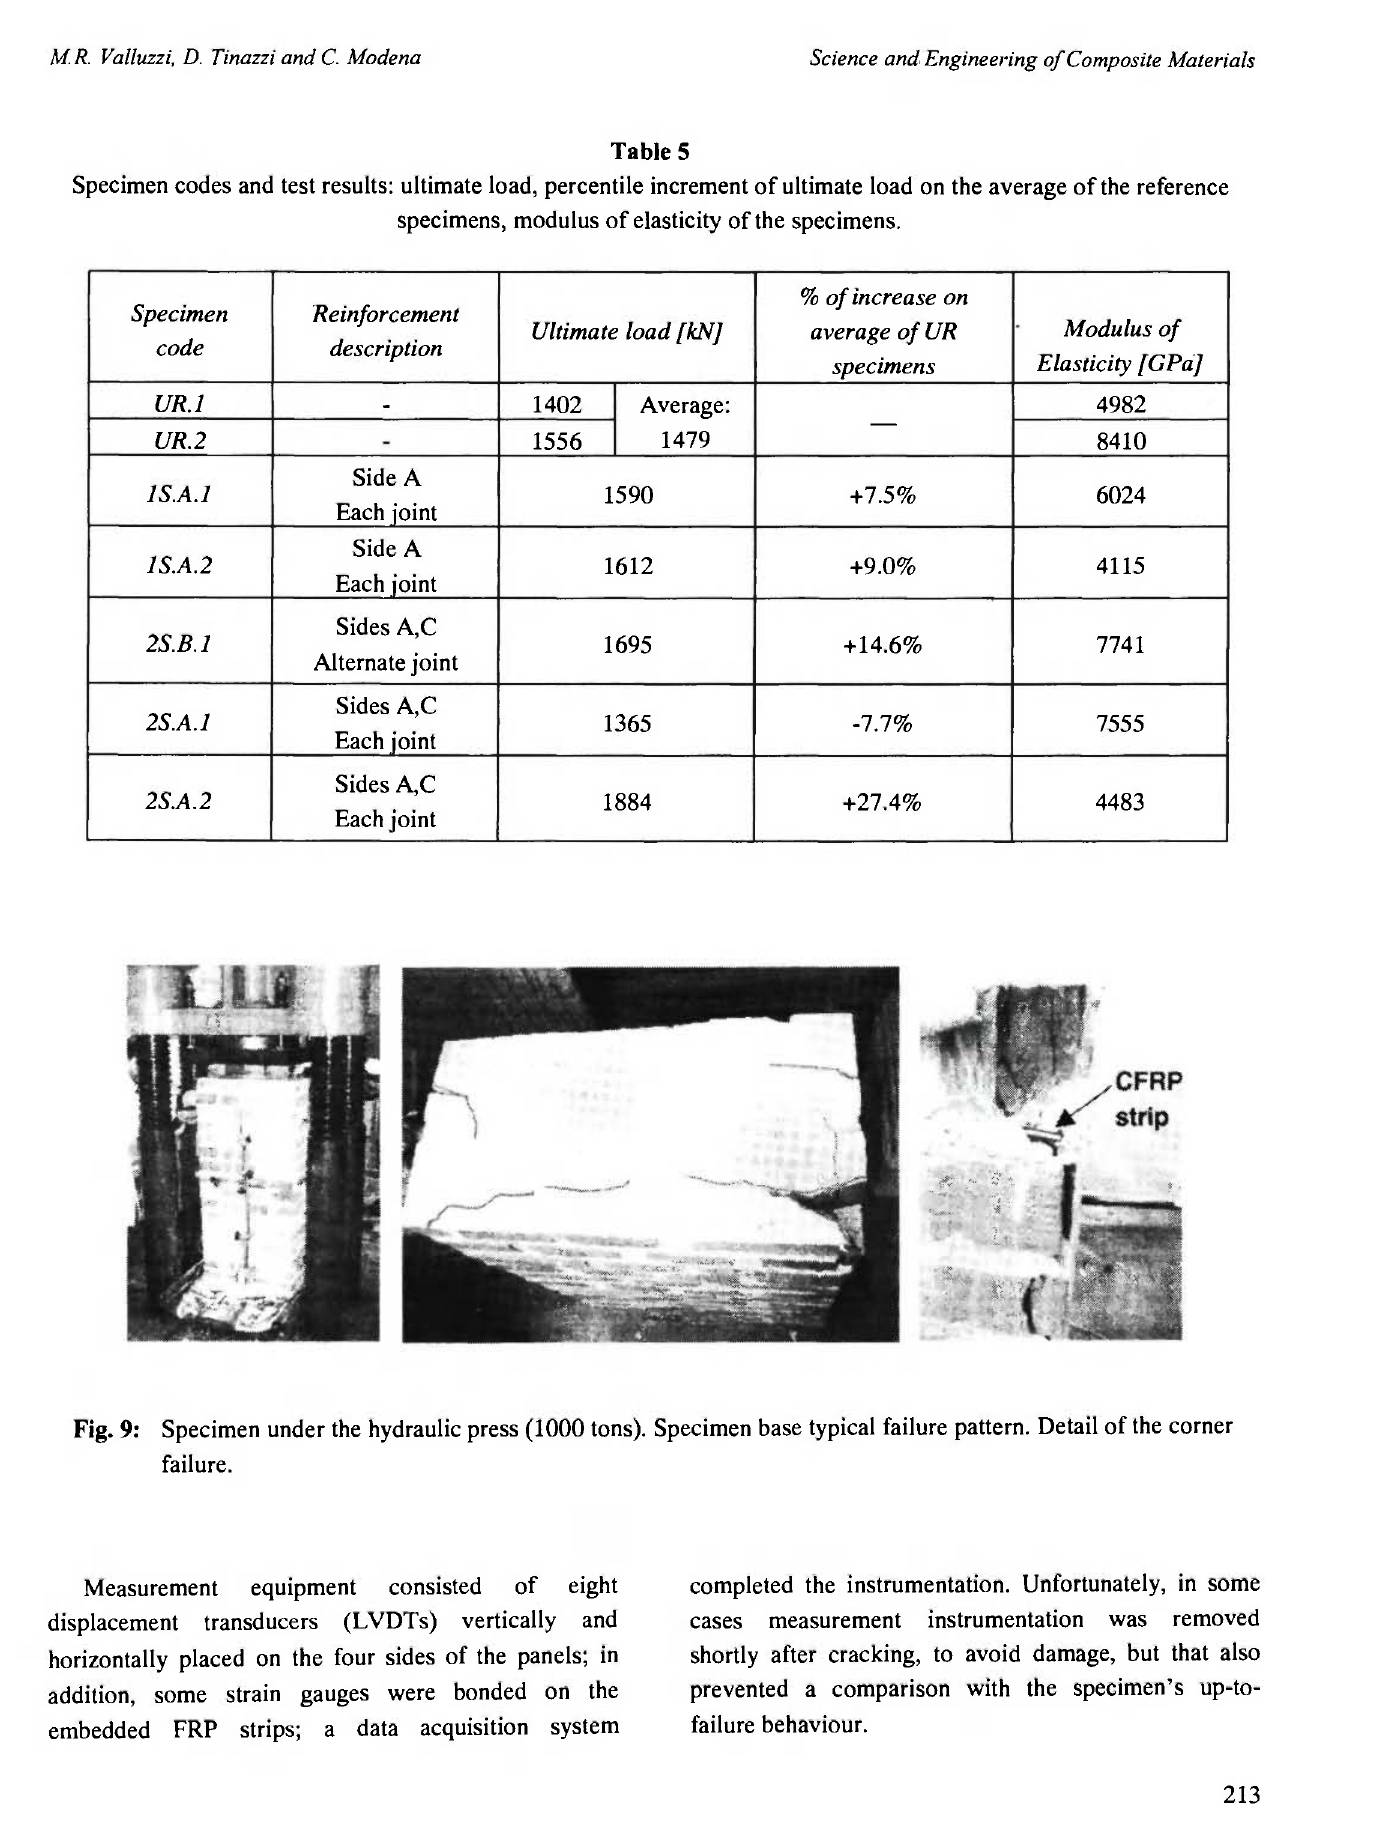
Fig. 9: Specimen under the hydraulic press (1000 tons). Specimen base typical failure pattern. Detail of the corner